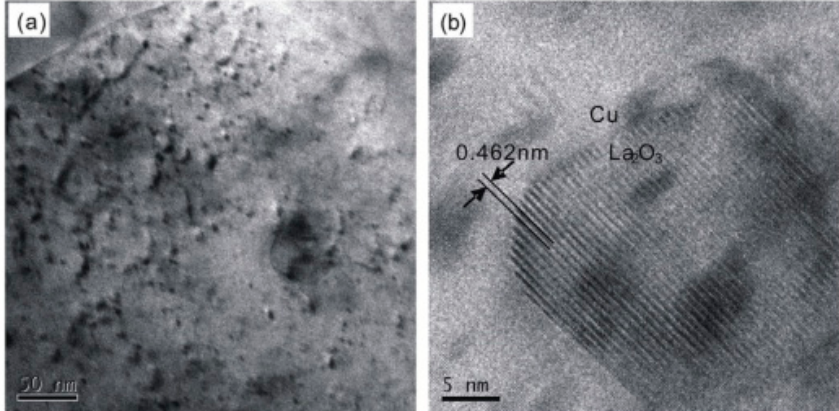
Figure 4. TEM images of Cu–1.3 wt.% La 2 O 3 composite: ( a ) bright field image; ( b ) high resolution TEM image [17]. Reprinted/adapted with permission from Ref. [17]. Copyright year 2019, Elsevier.